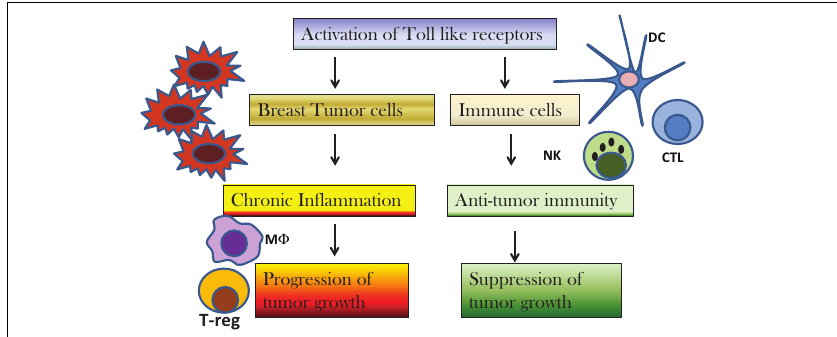
FIGURE 1 | Diagram to depict the effect of activation of toll-like receptors (TLRs) on breast cancer cells versus immune cells . Activation ofTLRs on breast cancer cells results in chronic inflammation and recruitment of macrophages (M Φ ) and regulatoryT-cells (T-reg) in the tumor microenvironment that cause suppression of immune responses and progression of tumor growth. Activation ofTLRs byTLR agonists cause infiltration of dendritic cells (DC), natural killer (NK) cells, and cytotoxicT-cells (CTL) that result in suppression of tumor growth.